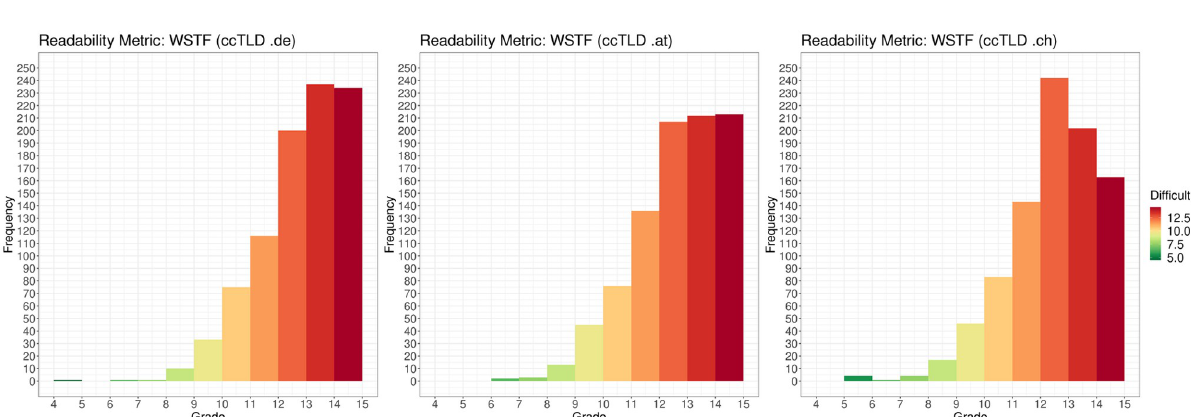
Fig 4. Distribution of readability values on the Flesch Reading Ease scale for each ccTLD (“.de”, “.at”, “.ch”). Difficulty indicated by color, with dark green as the highest readability (90–100) and dark red as the lowest readability (0–10). Note: For consistency reasons, the x axis is reverted and ranges from 100 to 0.